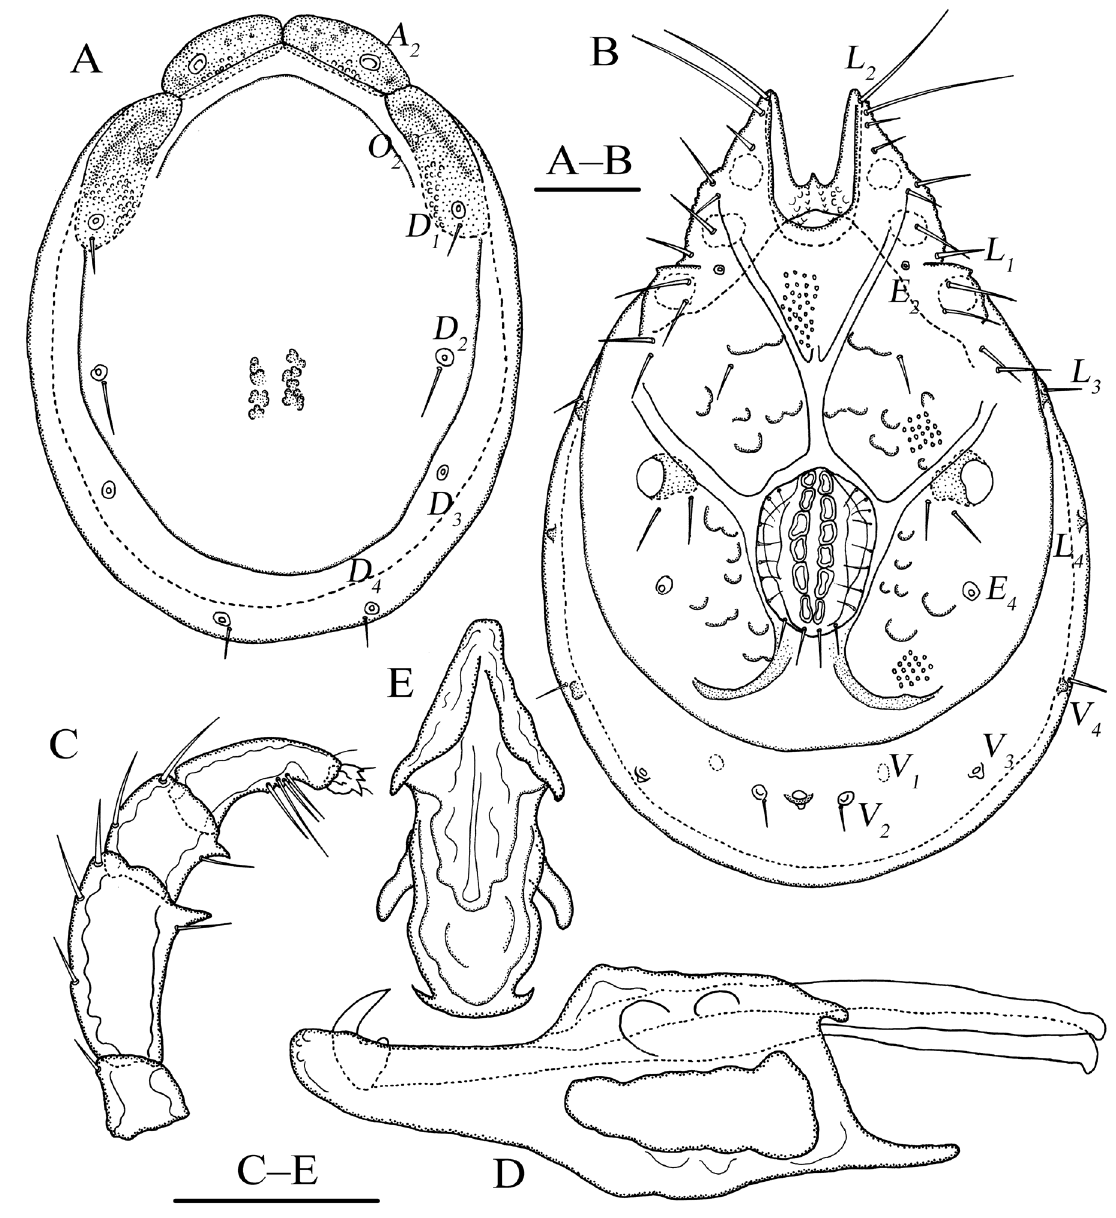
Fig. 9. Torrenticola wuyiensis Gu & Guo sp. nov., ♂ , holotype (FJ-TO-20180807). A . Dorsal view. B . Ventral view. C . Palp, lateral view. D . Infracapitulum and chelicera. E . Ejaculatory complex. Scale bars = 100